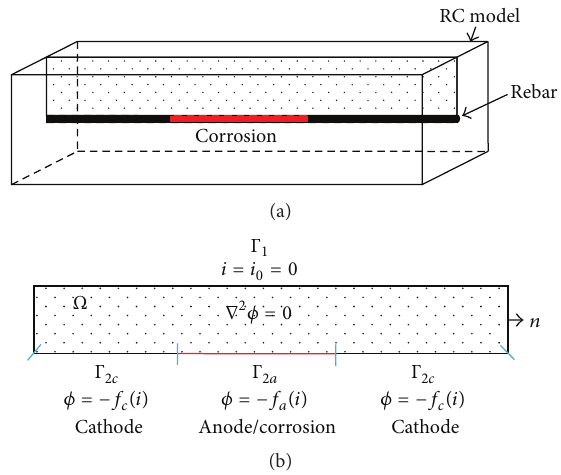
Figure 1: (a) RC model with single rebar; (b) 2D model of RC for BEM